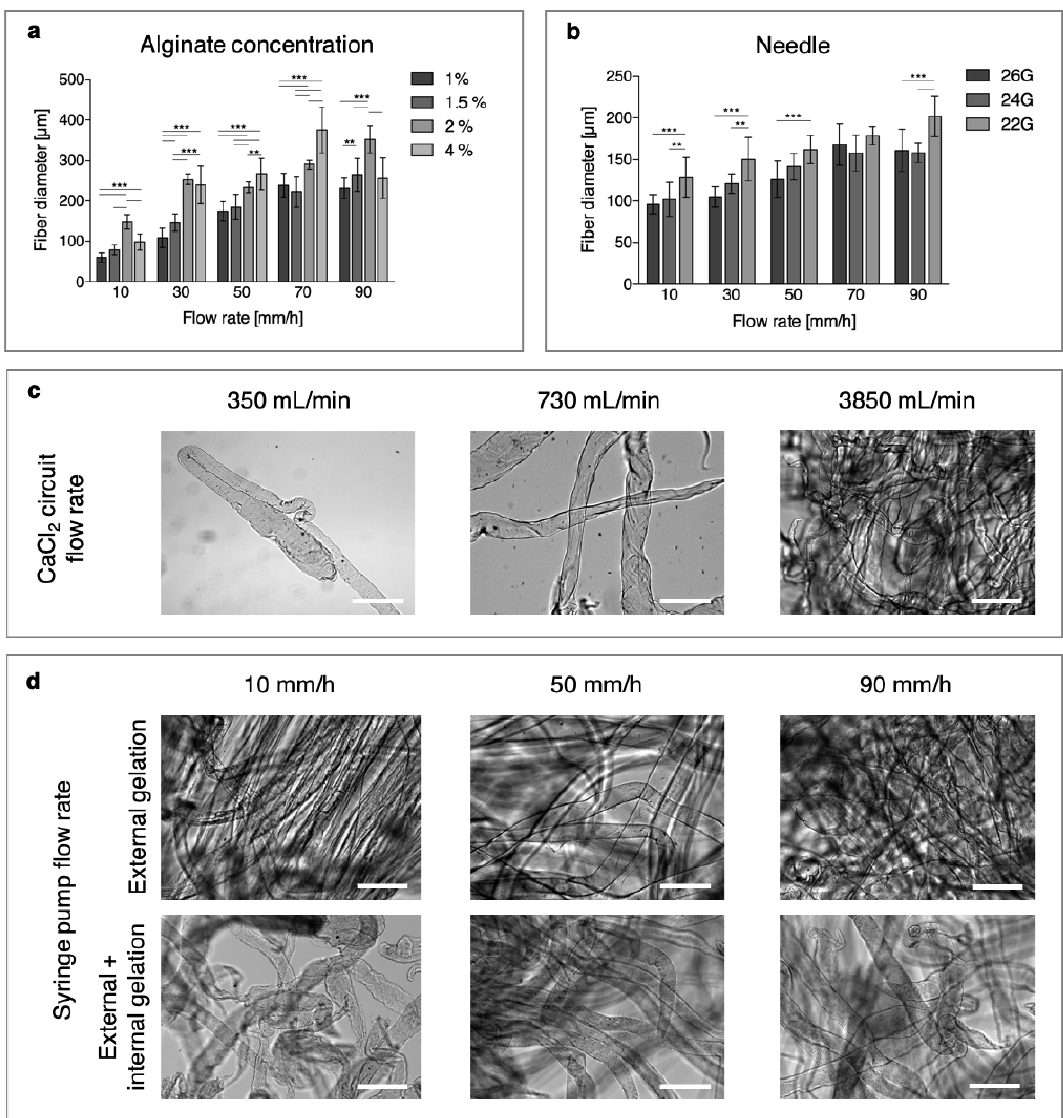
Figure 2. ( a ) Effect of alginate concentration and syringe pump flow rate on fiber dimensions. ( b ) Effect of needle dimension on fiber diameter (* p < 0.05, ** p < 0.01, *** p < 0.001). ( c – d ) Qualitative influences of parameters on microfiber dimensions and morphologies: ( c ) effects of CaCl 2 circuit flow rates and ( d ) effects of alginate solution flow rates. Scale bar = 500 μ m.